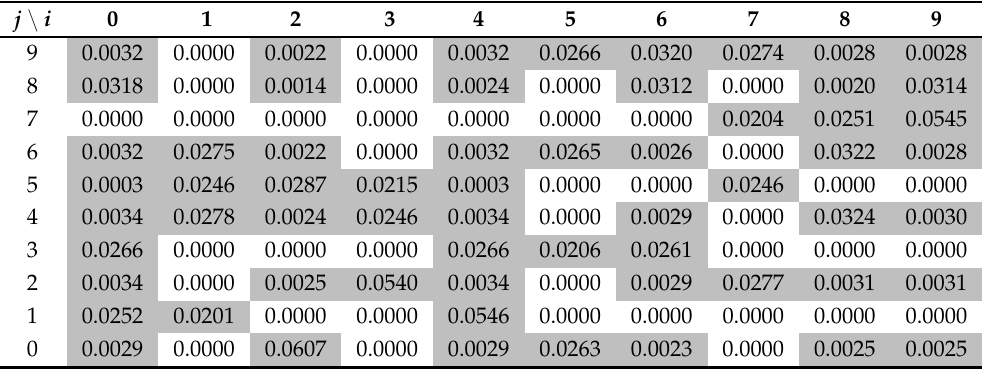
Table 8. Probabilities p ij in the resulting optimal discrete skeleton in Example 3.